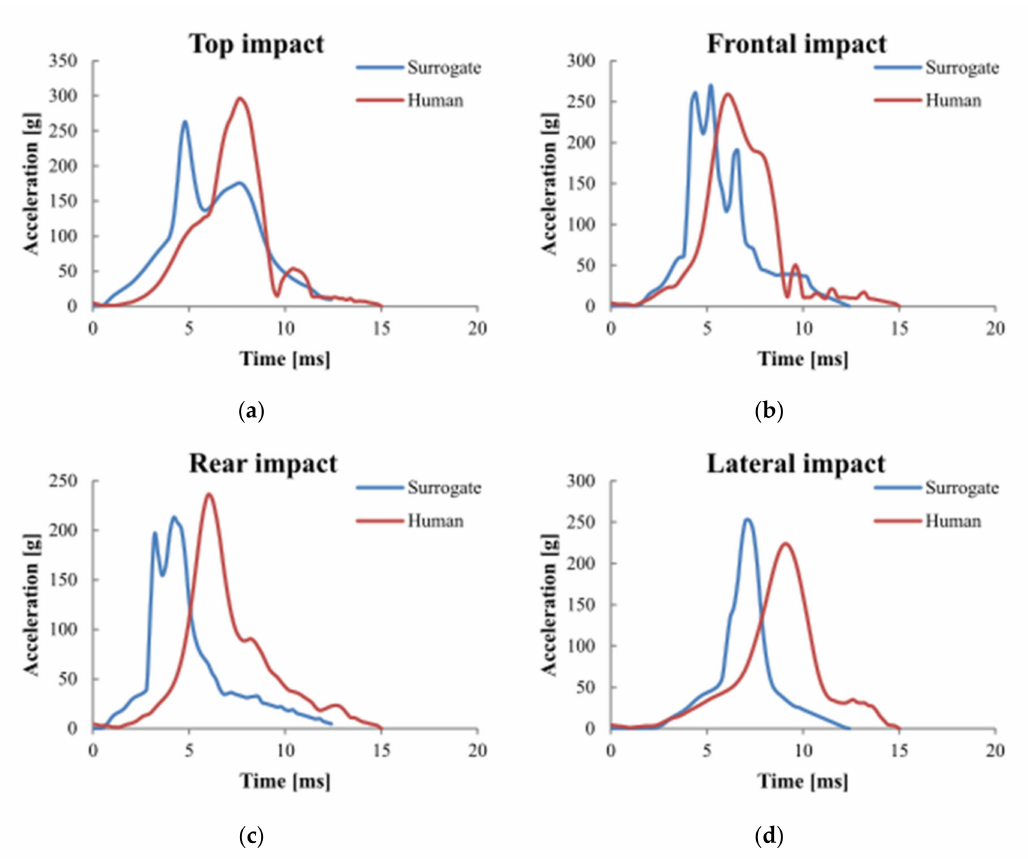
Figure 10. The acceleration evolution comparison of both head models used for each impact location.